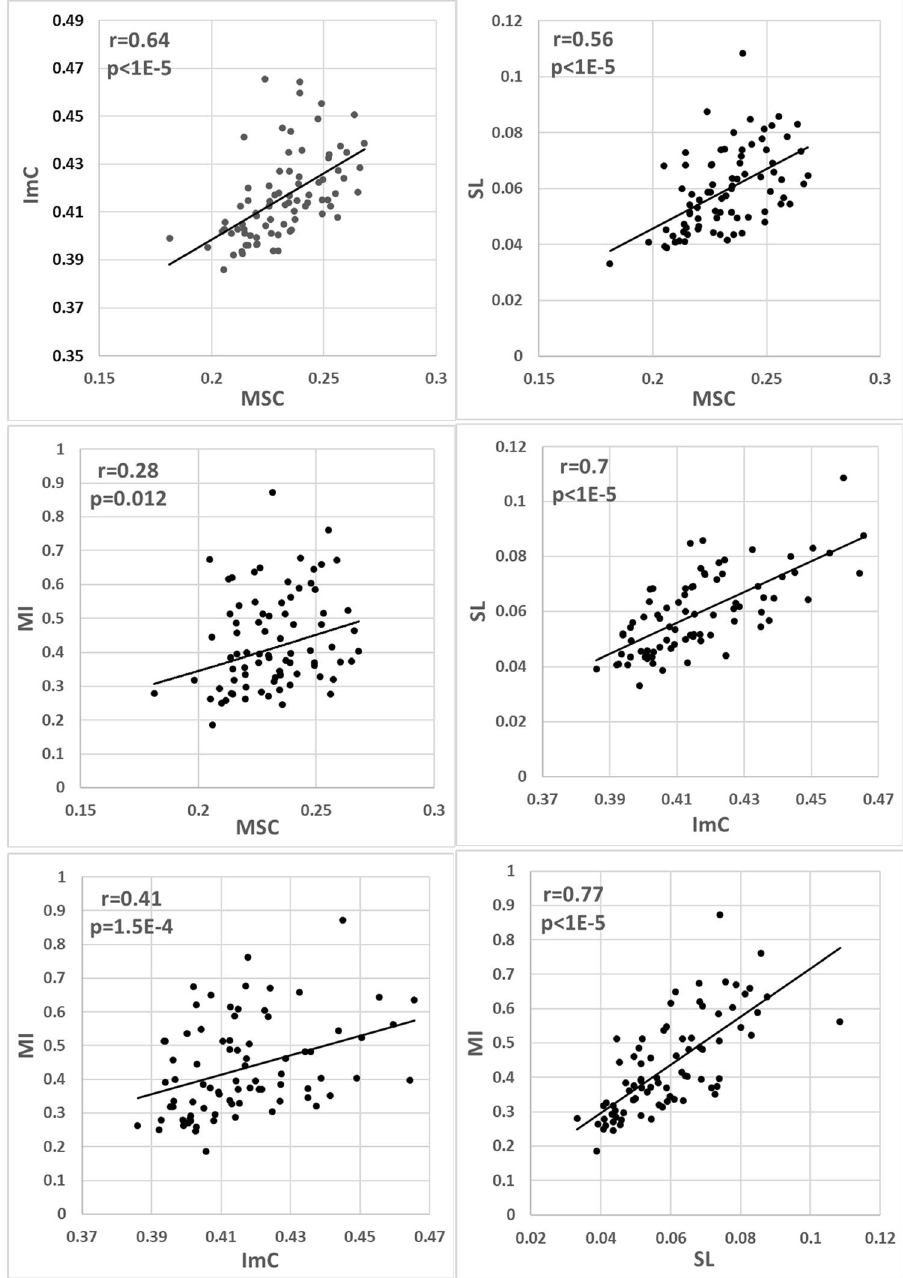
Figure 3. Correlation between various functional connectivity markers: MSC and ImC, MSC and SL, MSC and MI, ImC and SL, ImC and MI, SL and MI. The calculated Spearman correlation coefficients r between the markers and corresponding p- values are indicated ( n = 80). The p < 0.00076 (| r |> 0.37) indicates statistical